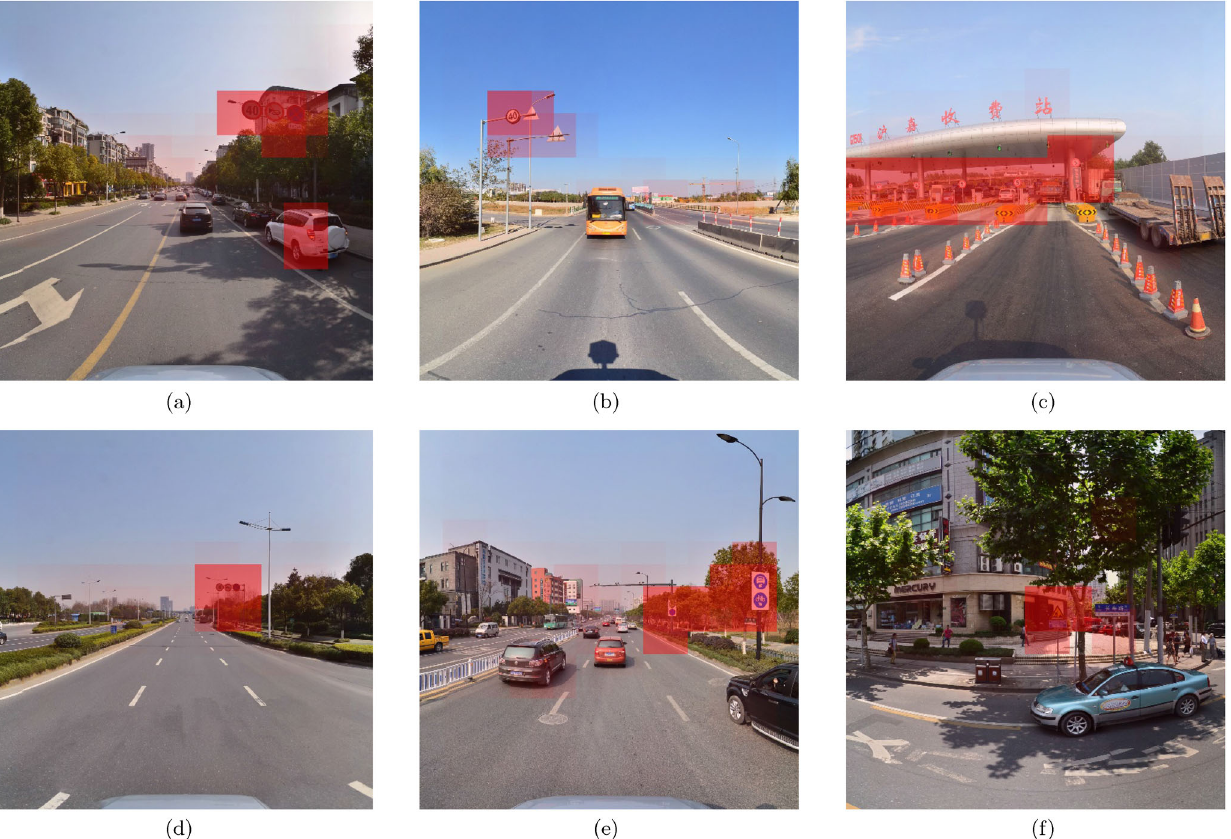
Fig. 4 Block score maps predicted by BlockNet. Blocks with deeper red coloring block with higher probability of containing traffic signs. These results demonstrate that our BlockNet produces correct block proposals. A great many irrelevant areas are filtered out; traffic signs occupy a relatively larger proportion of the block